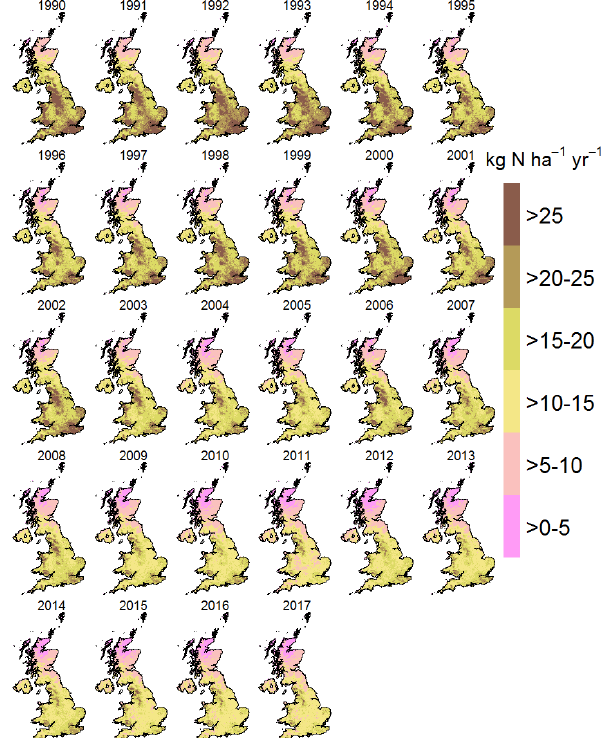
Figure 9. Spatial distribution of total nitrogen (N) deposition over the UK terrestrial surface, 1km × 1km resolution, from 1990 to 2017, for grid average land cover (ktNyr − 1